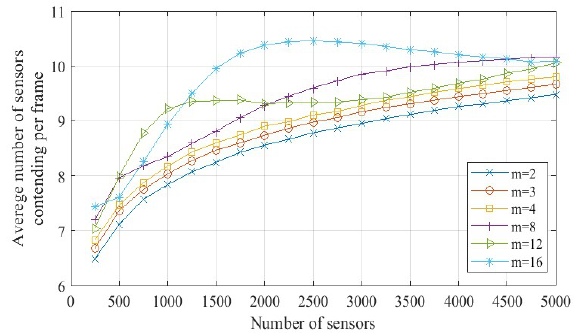
Figure 6. Average number of contending sensors per frame during the collision resolution